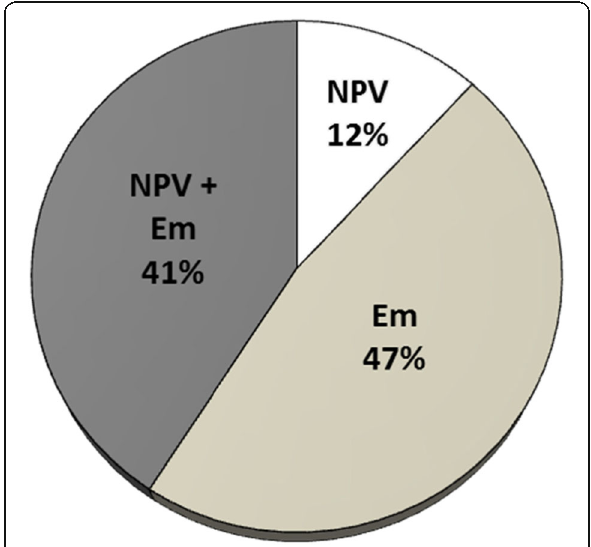
Fig. 8 Average number/eggs/day of Spodoptera littoralis female previously treated as 2nd instar larvae with Spli MNPV Em 0.05 ppm, Em 1 × 10 4 BIPs, and Em 0.05 ppm + SpliMNPV 1 × 10 4